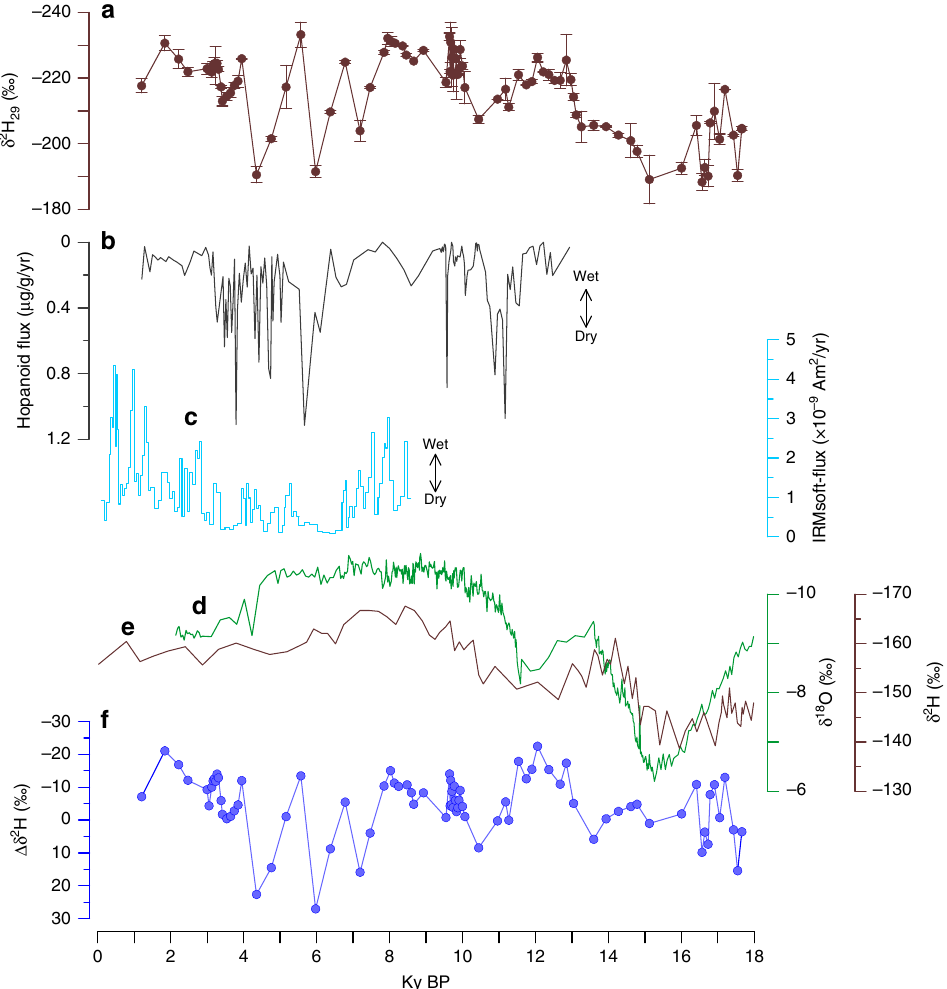
Fig. 4 Comparisons of paleohydrological records. a ZK-5 δ 2 H 29 values. b ZK-3 hopanoid fl ux 12 . c IRM soft- fl ux in stalagmite HS4 10 . d The calcite δ 18 O record from Sanbao Cave 14 . e The C 29 and C 31 n -alkane weight-averaged δ 2 H values of SO188-342KL 37 over the last 18 ky. f The Δδ 2 H (between Sanbao Cave carbonate and ZK-5 leaf waxes). Error bars represent 1 s.d. of replicate